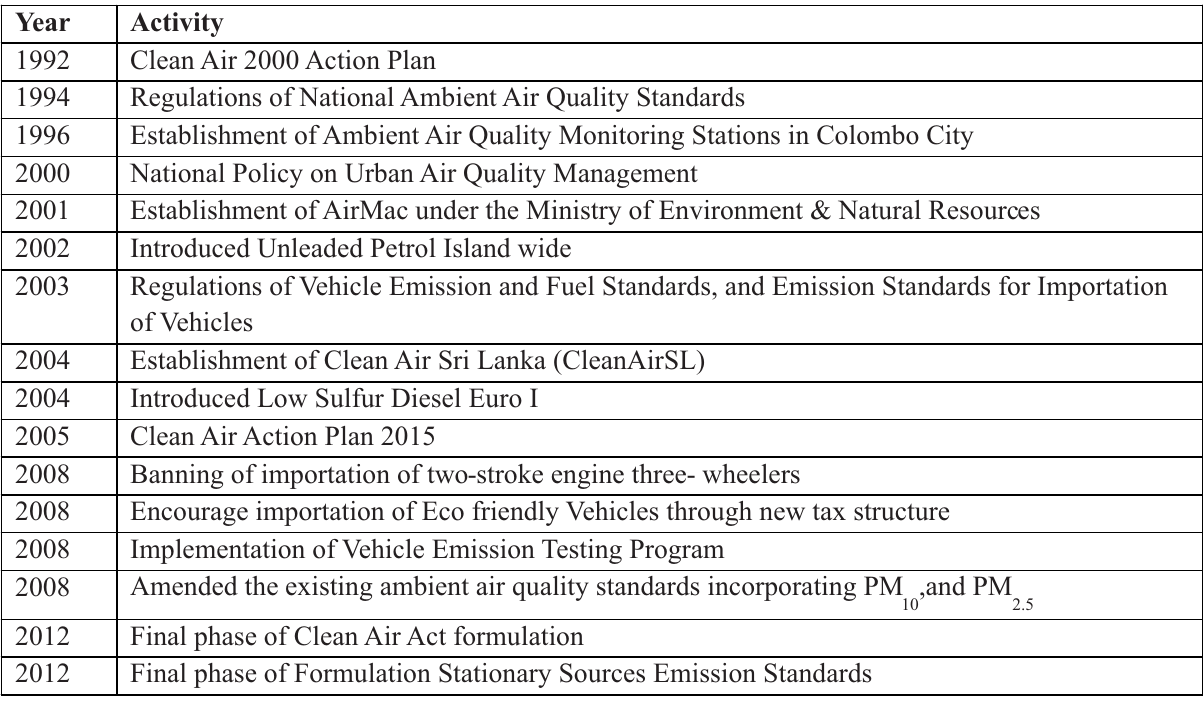
Table 5: Major steps implemented to mitigate outdoor air